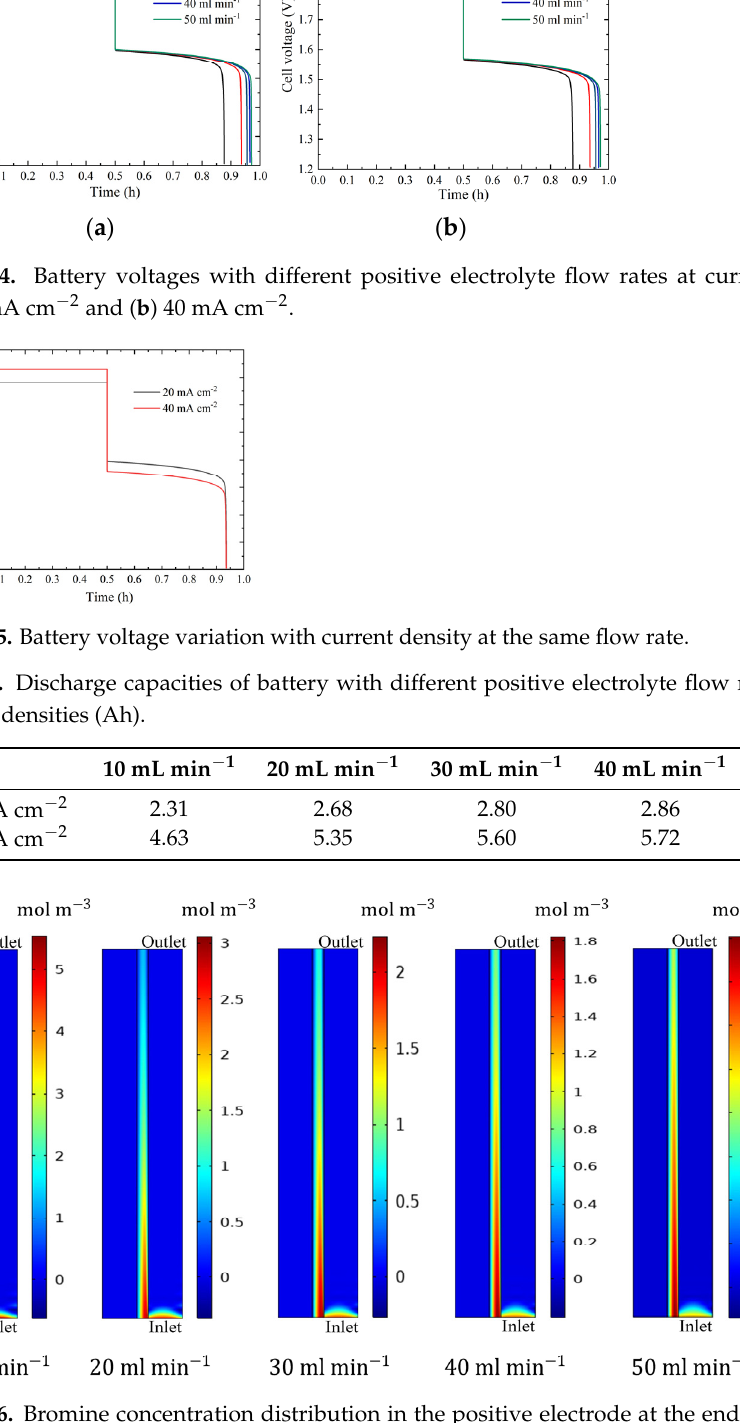
Figure 6. Bromine concentration distribution in the positive electrode at the end of discharge for battery with different positive electrolyte flow rates at a current density of 20 mA cm − 2 .